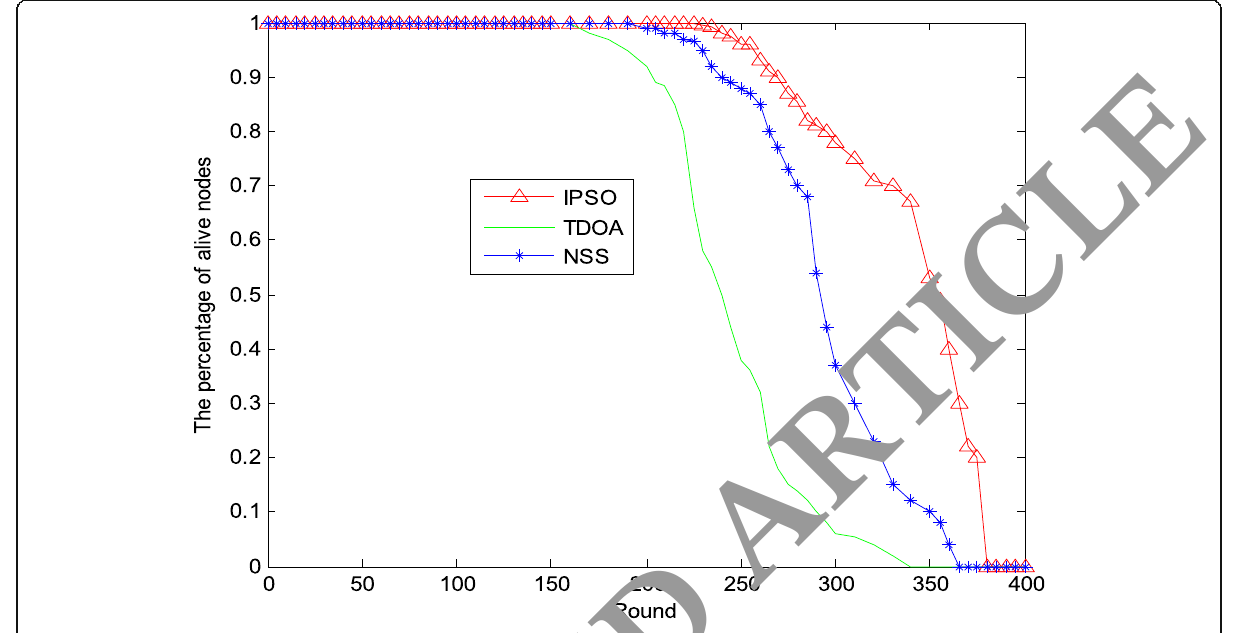
Fig. 7 Comparison of the percentage of alive nodes of three algorithms